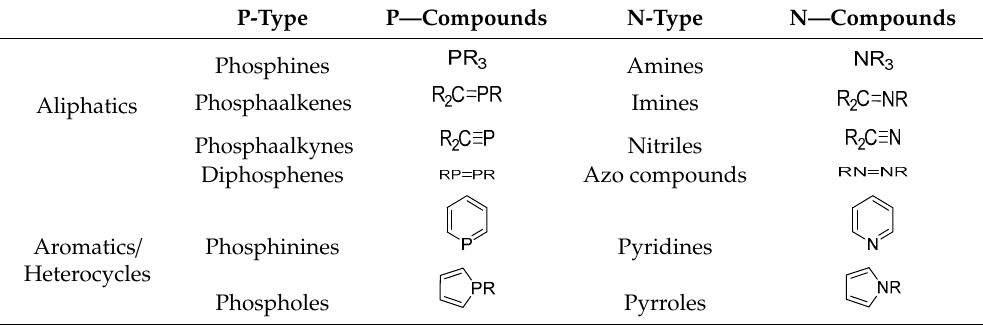
Table 1. Overview of some organo phosphorous (P +III ) compounds and structural related amine compounds.